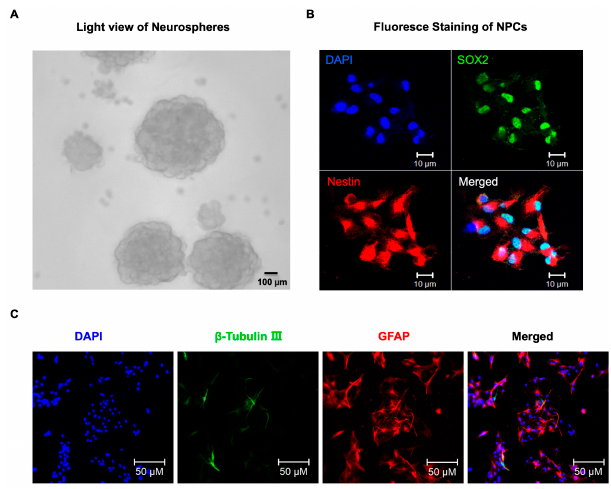
Figure 1. Identification of neural progenitor cells (NPCs). ( A ) Light view of NPCs, Scale bar = 100 µ m. ( B ) Immunostaining of NPCs for DNA marker DAPI (blue), the NPCs markers SOX2 (green), and nestin (red). Scale bar = 10 µm. ( C ) Representative immuno fl uorescence images of NPCs that di ff erentiate into neurons and astrocytes after 3 day’s di ff erentiation culture. Double immuno fl uo- rescent staining of cells for β -tubulin III (neuronal marker, green) and GFAP (astrocyte marker, red). The nuclei are counterstained with DAPI (blue). Scale bars = 50 µm. 2.1. Sevo fl urane Induced the Decrease of Migration in NPCs Harvested from WT Mice We then exposed the NPCs harvested from wild-type (WT) mice to 4.1% sevo fl urane for 4 h, and the treated NPCs were subjected to wound healing assay. We found that the sevo fl urane treatment led to a decrease in the distance the cells were able to move at 24 h after the sevo fl urane treatment (Figure 2A). Quanti fi cation of the migration distance showed that the sevo fl urane treatment signi fi cantly reduced cell migration at 24 h after the sevo fl urane treatment (Figure 2B). In addition, we conducted a transwell assay and observed a decrease in the number of cells that were able to migrate after 24 h of sevo fl u- rane treatment (Figure 2 C, D).